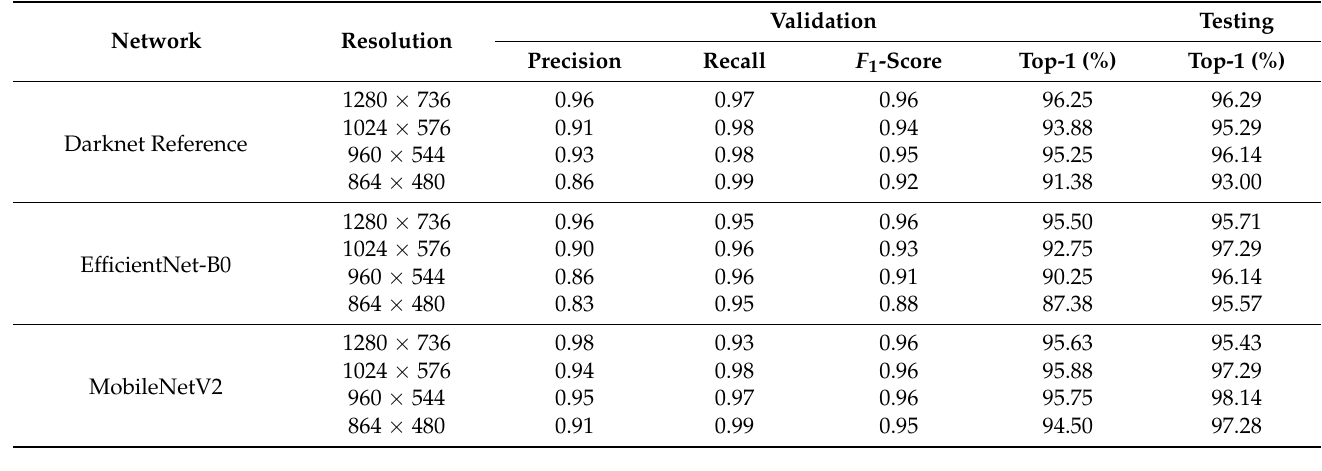
Table 5. Classification results for images with or without hair fescue.